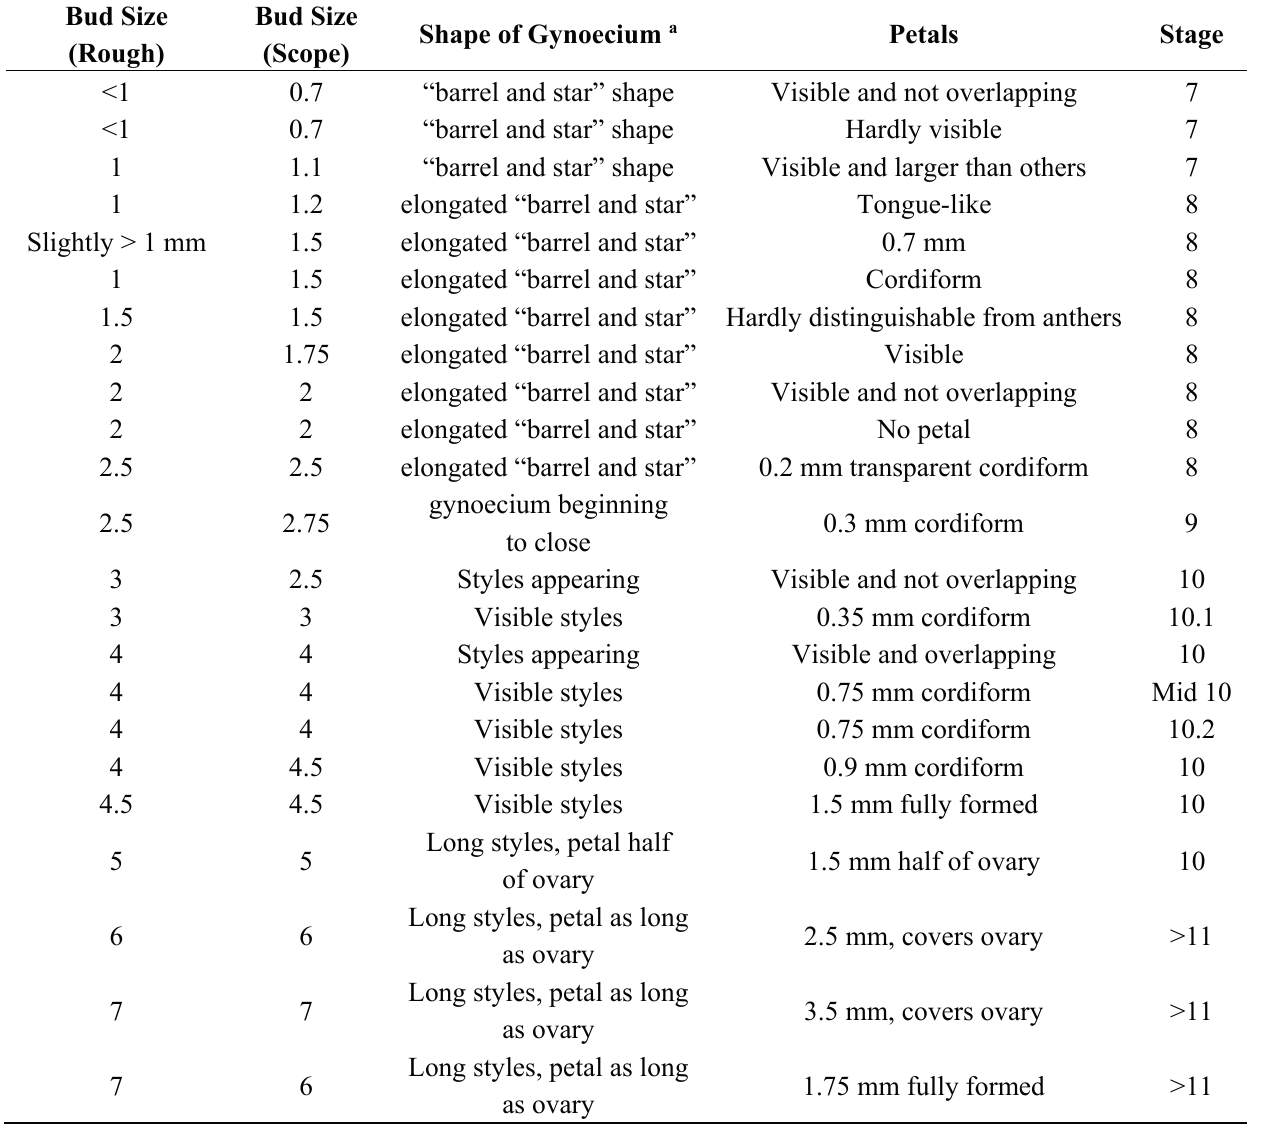
Table 2. Size observation and staging of female uninfected floral buds from four plants. Bud